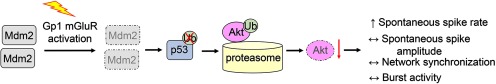
A working model for Mdm2, p53, and Akt in chronic activation of Gp1 mGluRs-induced refinement of neural network activity. Chronic activation of Gp1 mGluR leads to reduction of Mdm2, elevation of p53 and proteasomal degradation of Akt. Subsequently, neural network activity is adjusted, including elevation of spontaneous spike frequency and maintenance of spontaneous spike amplitude, network synchronization, and burst activity at the baseline.